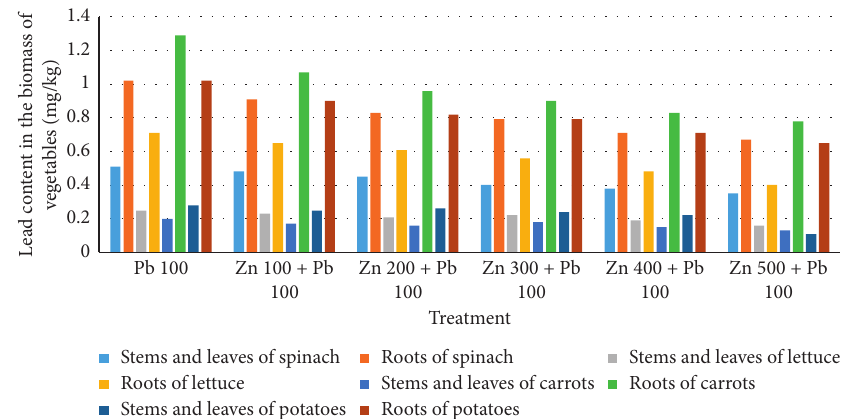
Figure 3: Effect of zinc on the accumulation of lead from soil to the biomass of the studied